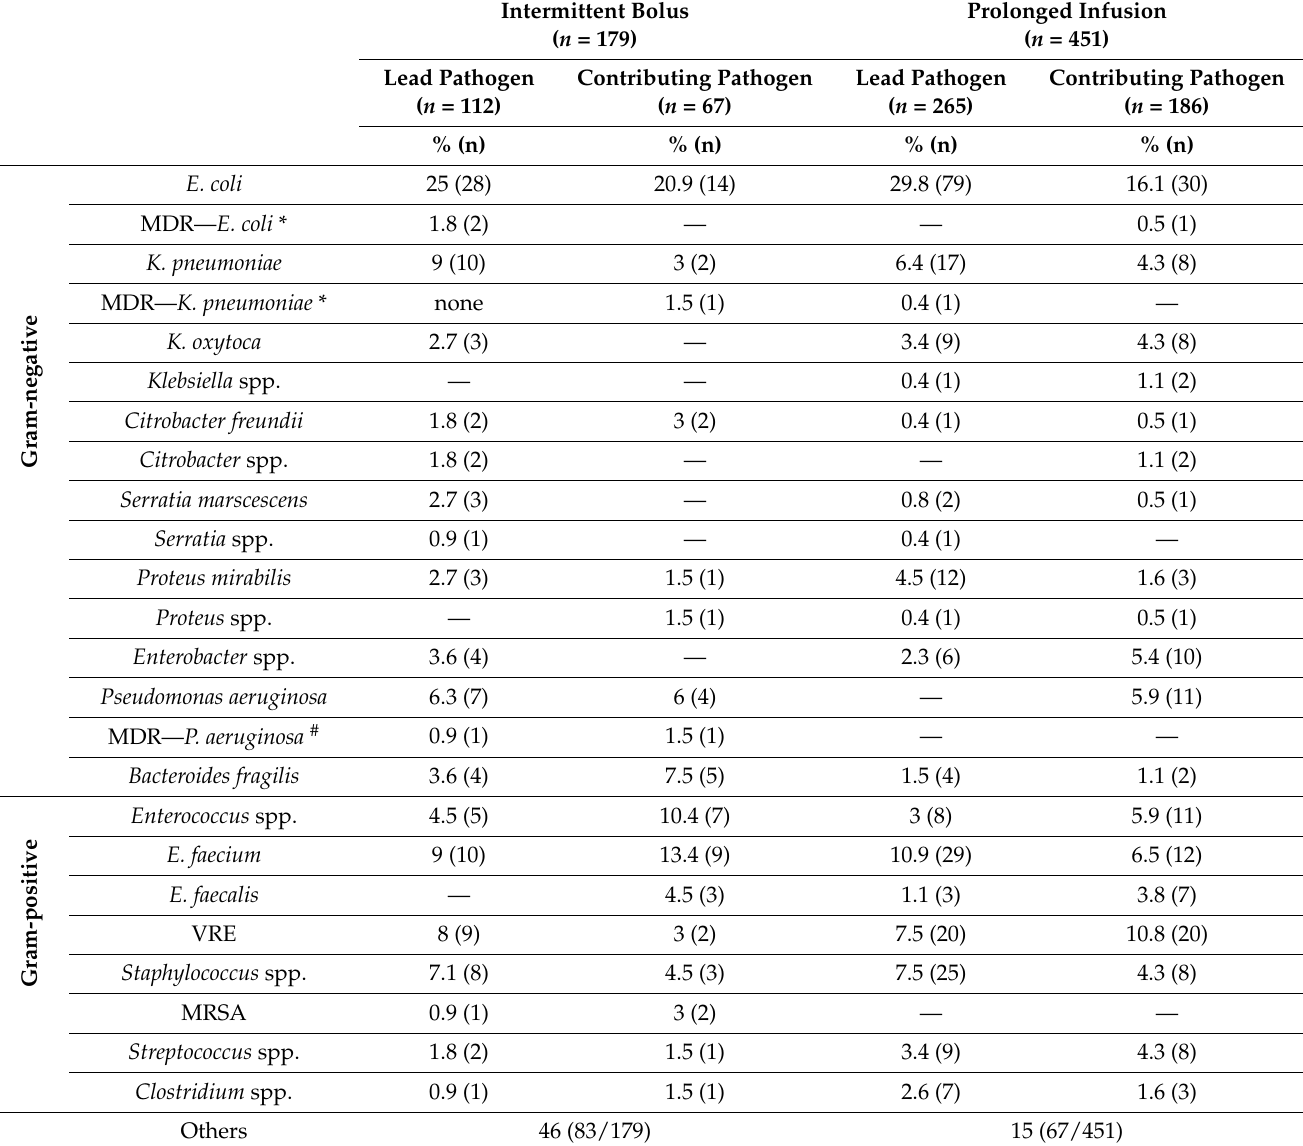
Table 2. Pathogen